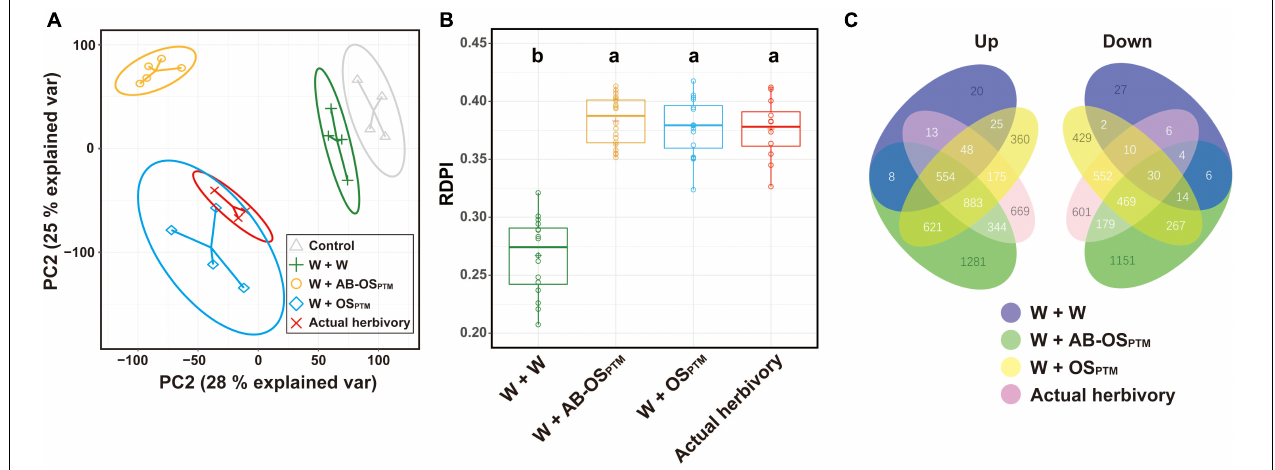
FIGURE 3 | The comparison of transcriptomic profile for all treatment groups. (A) PCA for gene expression matrix; 28% variance is explained in PC1 and 25% variance is explained in PC2; ellipse refers to the 95% confidence interval of each treatment group. (B) The boxplot of RDPI index for four herbivory treatment groups; data point is mapped to circle. (C) DEG overlap and difference for all treatment groups are exhibited as a Venn plot; the number of genes of each region is displayed on the corresponding